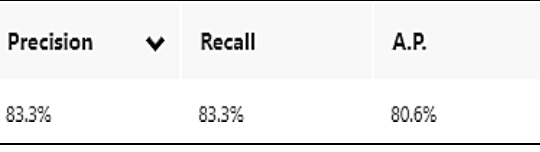
Figure 9. Model metrics